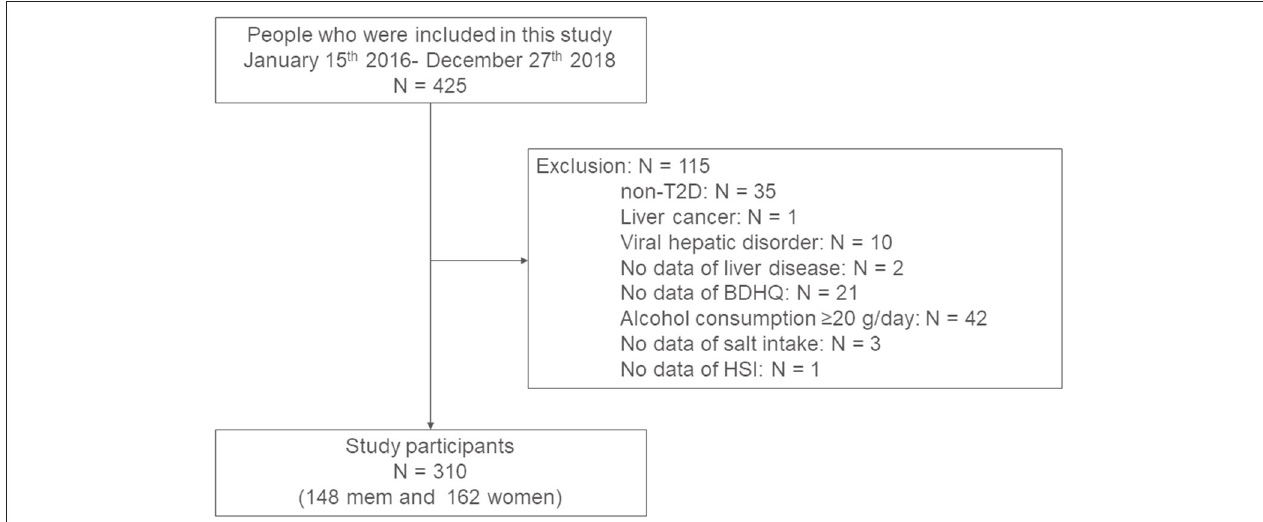
FIGURE 1 | Study flow diagram for the registration of patients. BDHQ, a brief-type self-administered diet history questionnaire; HSI, hepatic steatosis index; T2D, type 2